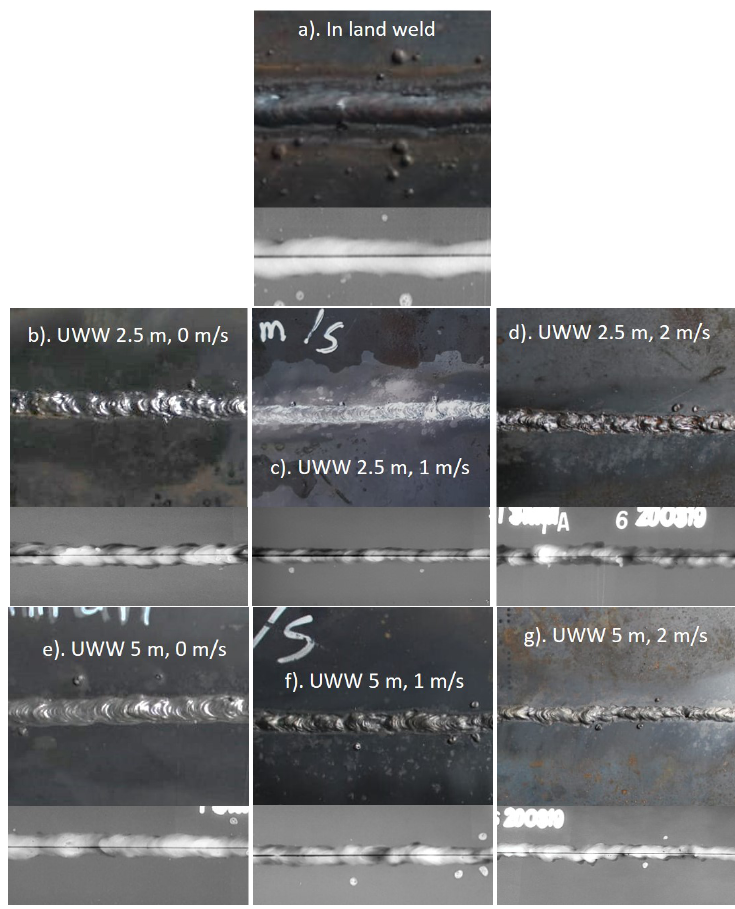
Figure 5: Welded joint appearance and radiographic test